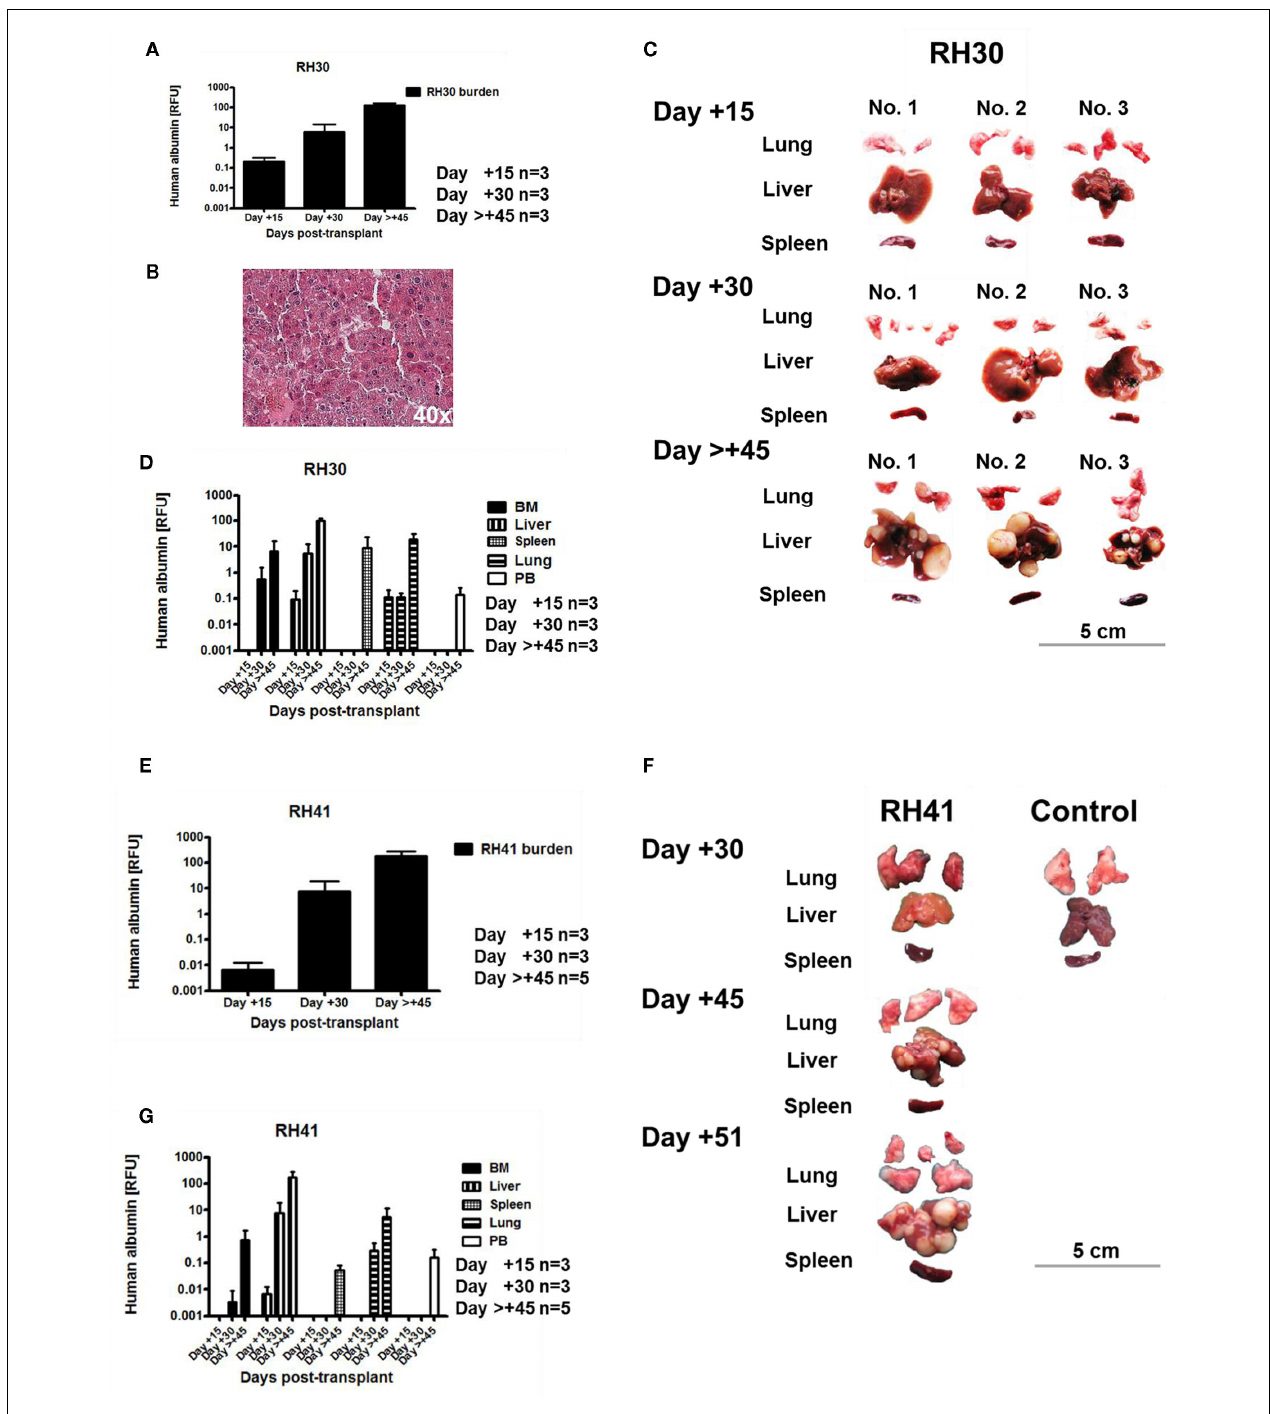
one representative histological analysis (B) , but was also detectable to a decreasing extent in lung, bone marrow (BM), spleen, and peripheral blood (PB) (C,D) . In parallel, injection of 1 × 10 6 RH41 cells was sufficient for engraftment of tumor cells. RH41 signals within analyzed compartments (BM, PB, liver, spleen, and lung) were detectable at day + 15 and increased by 18020-fold within 30days (E) . Most of RH41 engraftment occurred in liver and lung like shown by one representative example (F) , but was also detectable in bone marrow, blood, and spleen (G)